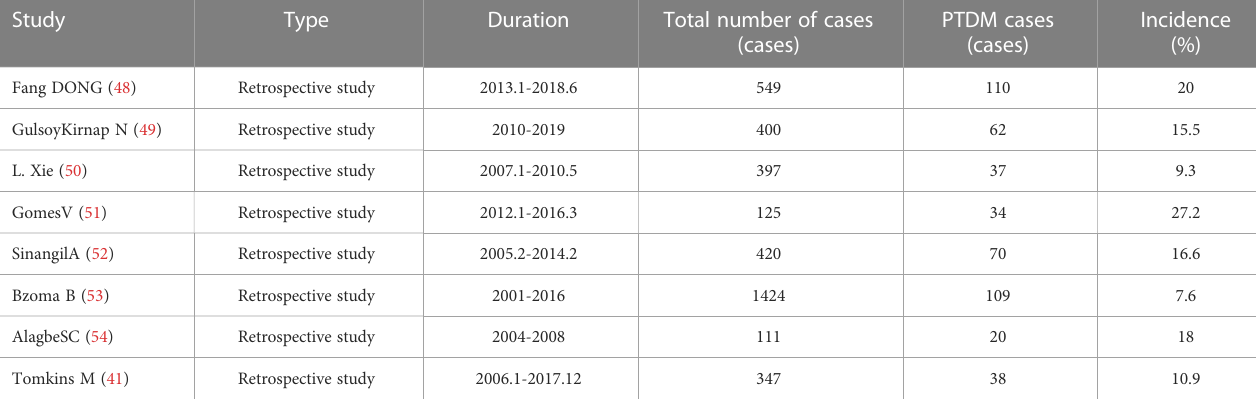
TABLE 2 Incidence of PTDM after kidney transplantation